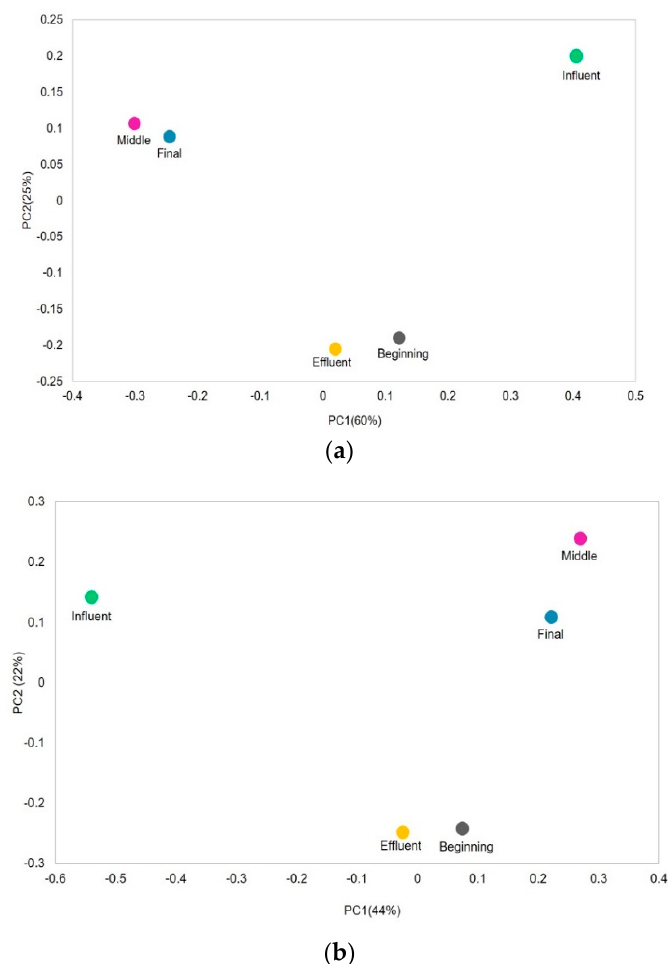
Figure 4. ( a ) Principal Coordinate Analyses (PCoA) plot based on weighted UniFrac distance between the different sampling sites of the biodigester. The percentage variation explained with first two principal components (P1, P2); ( b ) Principal Coordinate Analyses (PCoA) plot based on unweighted UniFrac distance between the different sampling sites of the biodigester. The percentage variation is explained with first two principal components (P1, P2).